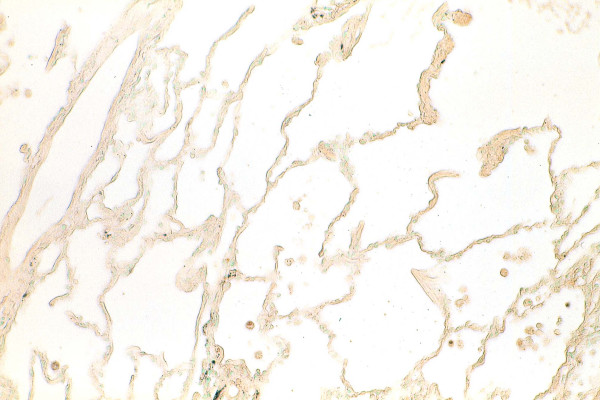
Immunohistochemical studies of ILK in non-neoplastic pulmonary tissue and in NSCLC tissue. a non-neoplastic pulmonary tissue: ILK was not detected in epithelial cells, while ILK expression was found in many stromal cells.